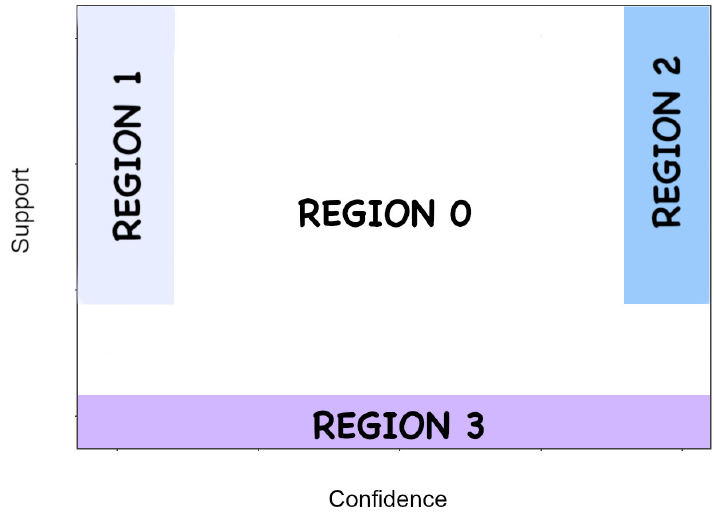
Figure 2. Structure of reduction based on significance (RBS)